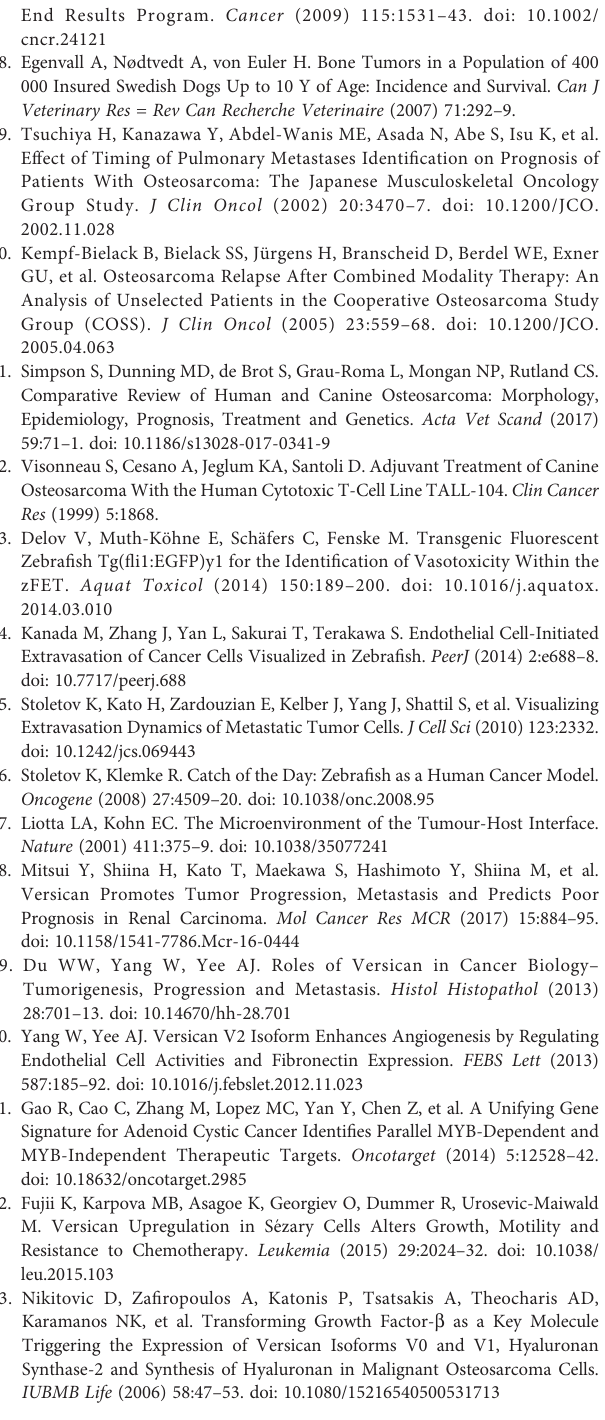
connectivity parameters by log2FC for HMPOS and (D) D17. (E) Bar graphs of top connected genes in the pathway, colored by log2FC for HMPOS and (F) D17. Supplementary Video 1 | A representative time-lapse video of circulating tumor cell clusters (cyan) extravasating from the inside/lumen of zebra fi sh blood vessels (red) into the surrounding extravascular cavity. SB = 20